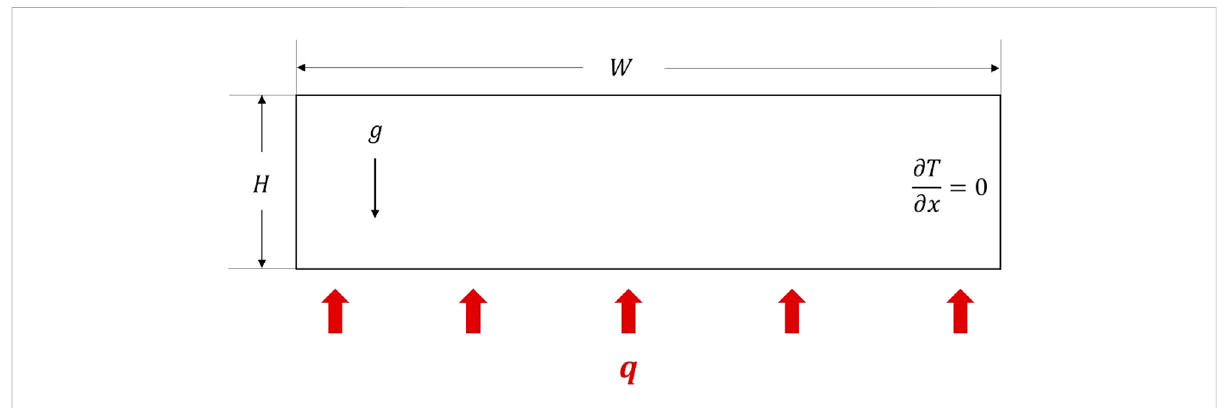
FIGURE 1 Physical model and coordinate system.